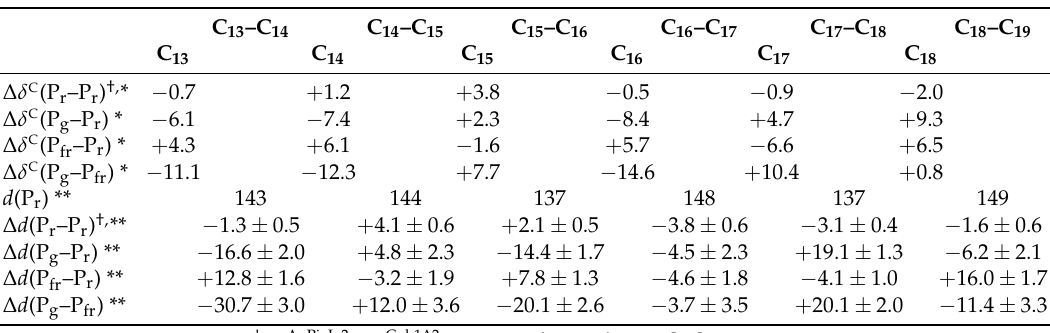
Table 1. Results of the inversion of the geometric sensitivity of 13 C chemical shifts shown in Figure 3 based on extensive QM/MM MD simulations and reported NMR measurements by Song et al. [68] for AnPixJg2 (switches from P r to P g ) and Cph1 ∆ 2 (switches from P r to P fr ). ∆ δ C (P x –P y ) is the experimental difference pattern of 13 C chemical shifts going from P x to P x ; d (P r ) denotes averaged bond lengths calculated from the MD trajectories of both proteins in their respective P r state; ∆ d (P x –P y ) is the change in bond length (together with uncertainty) going from P y to P x , predicted from principal component analysis and multivariate